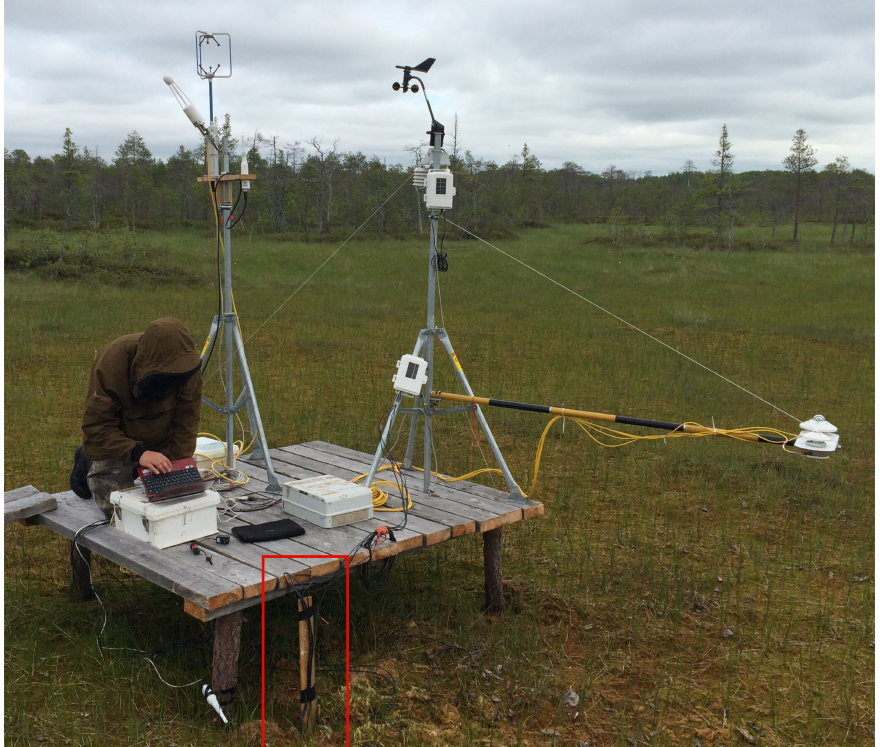
Figure 1. The landscape view and setup of measurements on Mukhrino bog (Khanty–Mansiysk region, Russia) in summer, 2019. The red rectangle shows the vertical string of temperature and heat flux sensors in the moss layer.